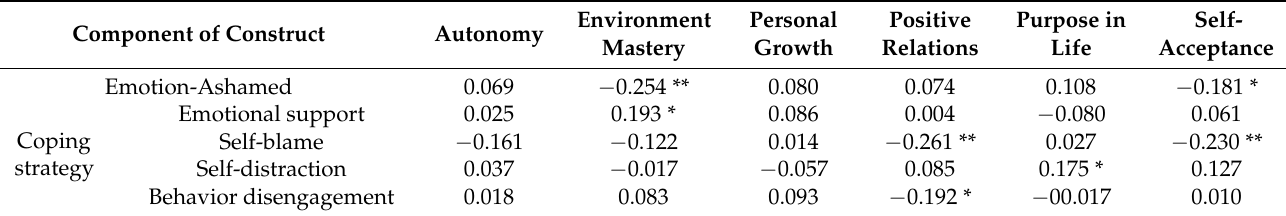
Table 5. The correlation coefficients between psychological well-being and components of emotion and coping strategy